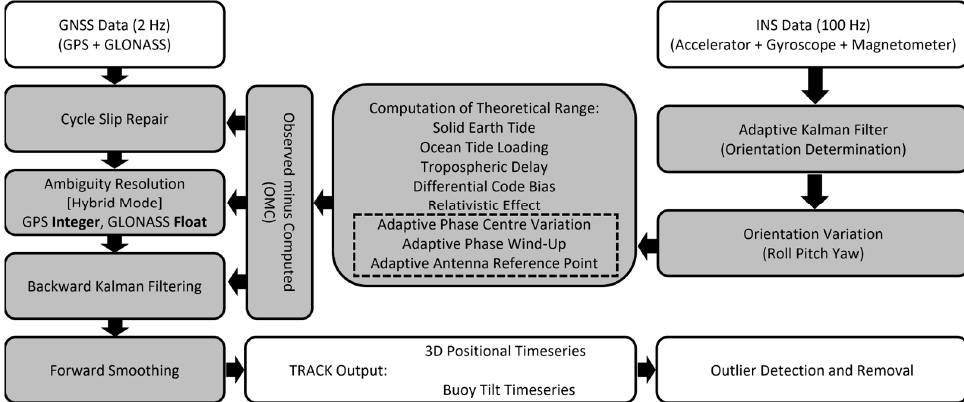
Figure 2. Block diagram of GNSS/INS data processing in TRACK. Shaded boxes refer to the steps within the TRACK processing suite.